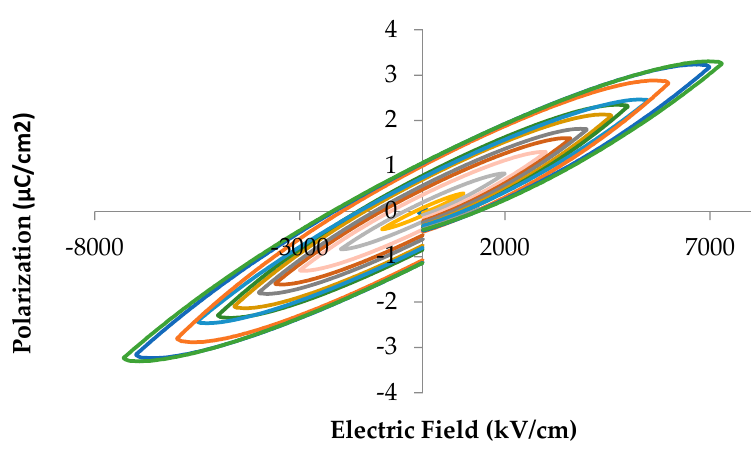
Figure 7. Hysteresis loop of pure PbZn 0.3 Ti 0.7 O 3 versus various applied electric fields.